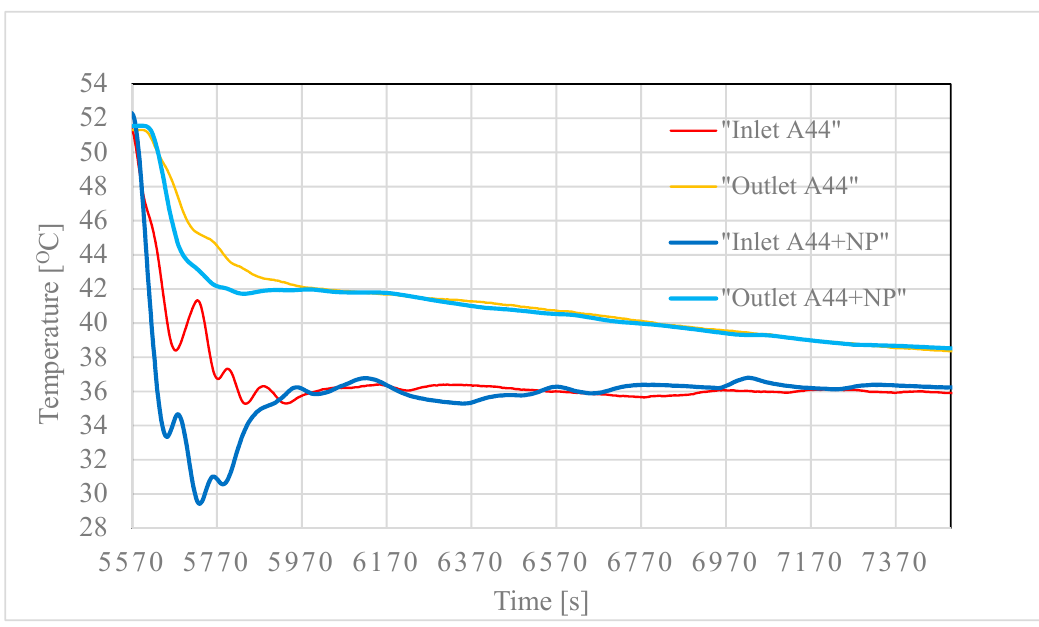
Figure 11. Comparison of HTF temperature evolution in case of pure A44 and A44 with nano-particles (A44 + NP) upon discharging.